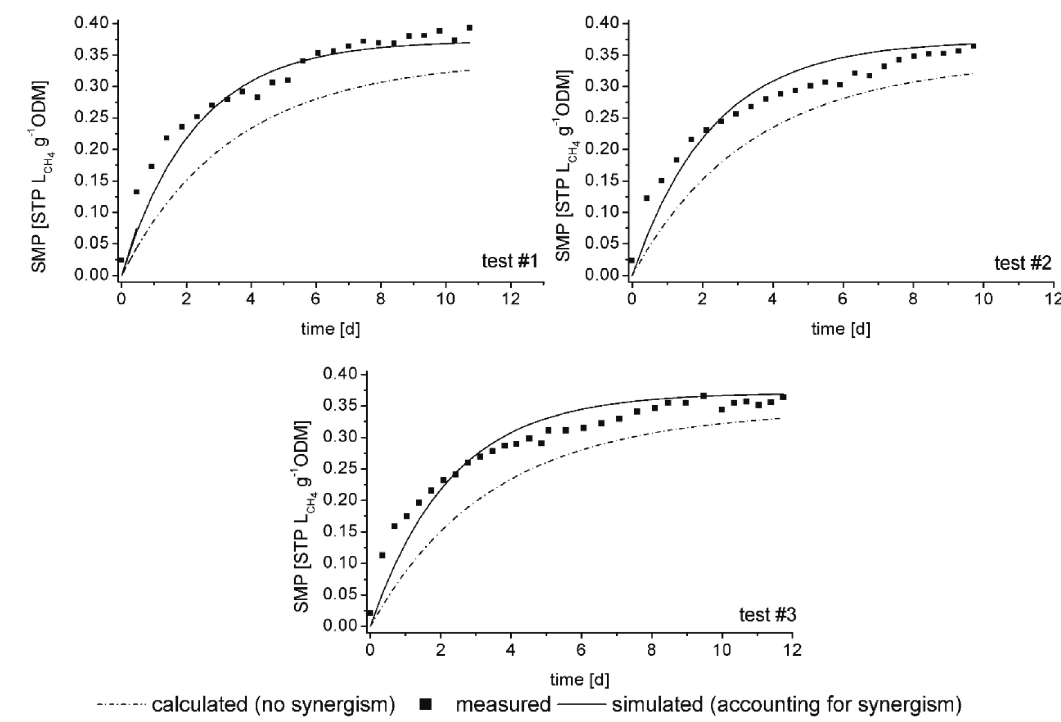
Fig. 3 – Evaluation of synergistic effects: scattered curve represents the measured methane production, dotted curve represents the predicted production in the hypothesis of no synergism, continuous line is the simulated production accounting for